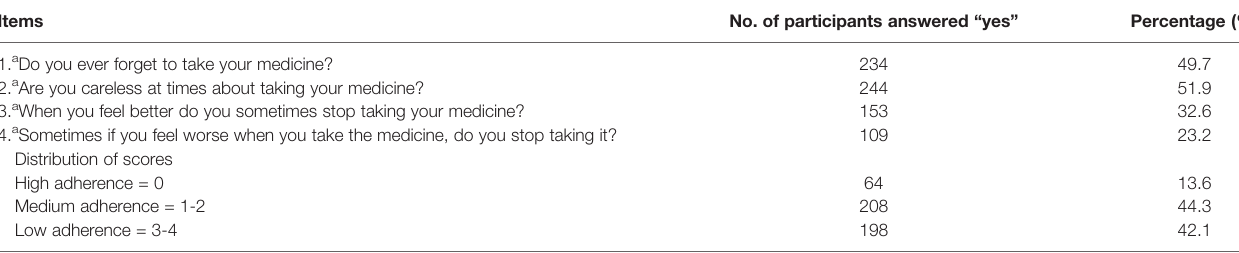
TABLE 3 | Medication adherence for inpatients with coronary heart disease, Changsha, Hunan, China(N = 470). Items